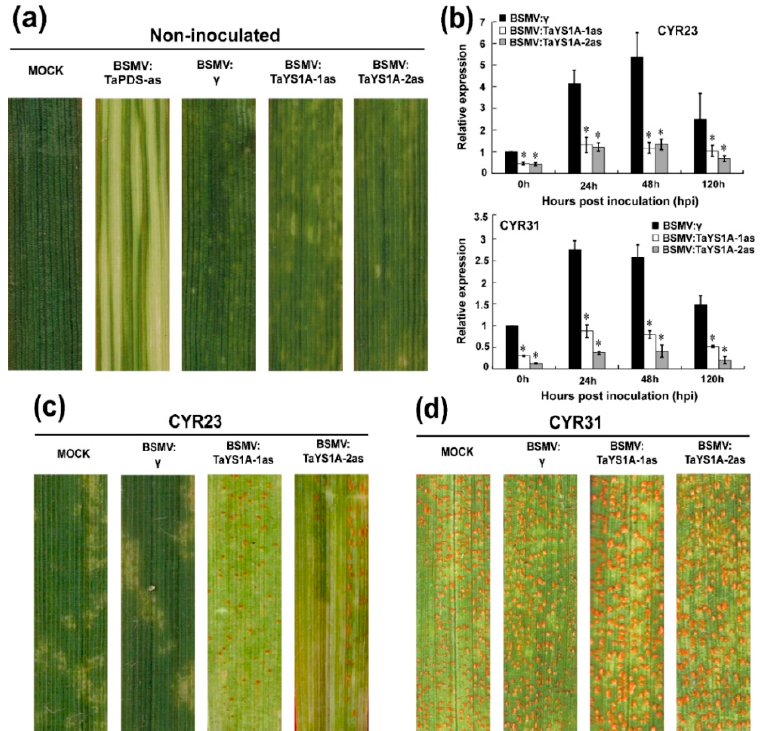
Figure 3. BSMV-mediated gene silencing (VIGS) of TaYS1A enhances wheat susceptibility to Pst . ( a ) At 10 dpi, chlorotic mosaic symptoms were observed on virus-inoculated leaves. Mock, second leaves of wheat seedlings were mechanically rubbed with 1 × Fes buffer. ( b ) Relative expression of TaYS1A in TaYS1A -silenced plants infected with the avirulent race CRY23 or virulent race CRY31, respectively. The comparative threshold (2 −ΔΔ CT ) approach was used to measure the relative transcript levels of TaYS1A . Data normalized with the transcription of wheat elongation factor, TaEF-1 α , and visualized as fold change compared to control at 0 h. BSMV: γ infected wheat leaves were used as a control. Values represent the mean ± standard errors of three independent biological samples. Asterisks designate significant differences ( p < 0.05) from BSMV: γ by the Student’s t -test. ( c , d ) Photographs of the fourth leaves infected with urediniospores of CRY23 ( c ) and CRY31 ( d ) were taken at 14 dpi.